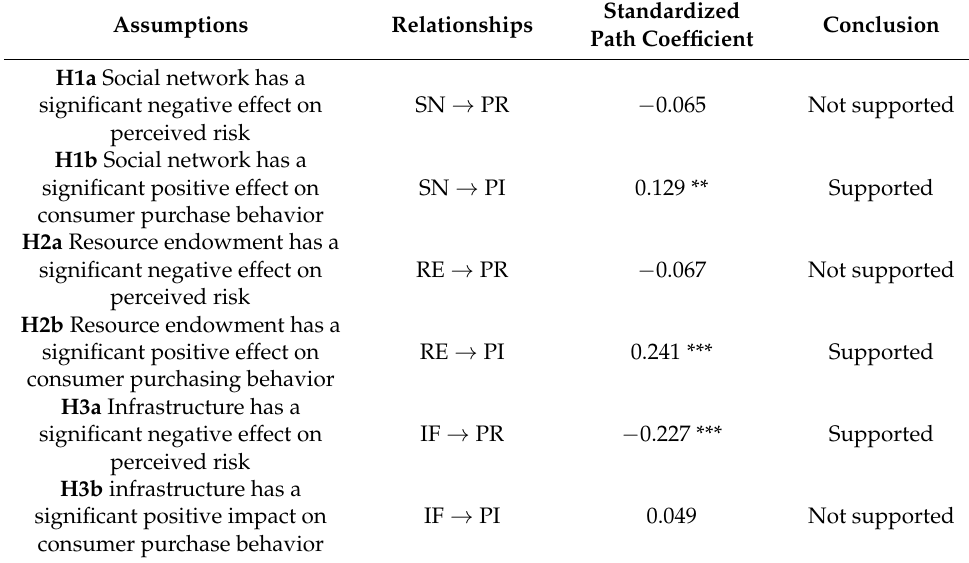
Table 7. Hypotheses testing